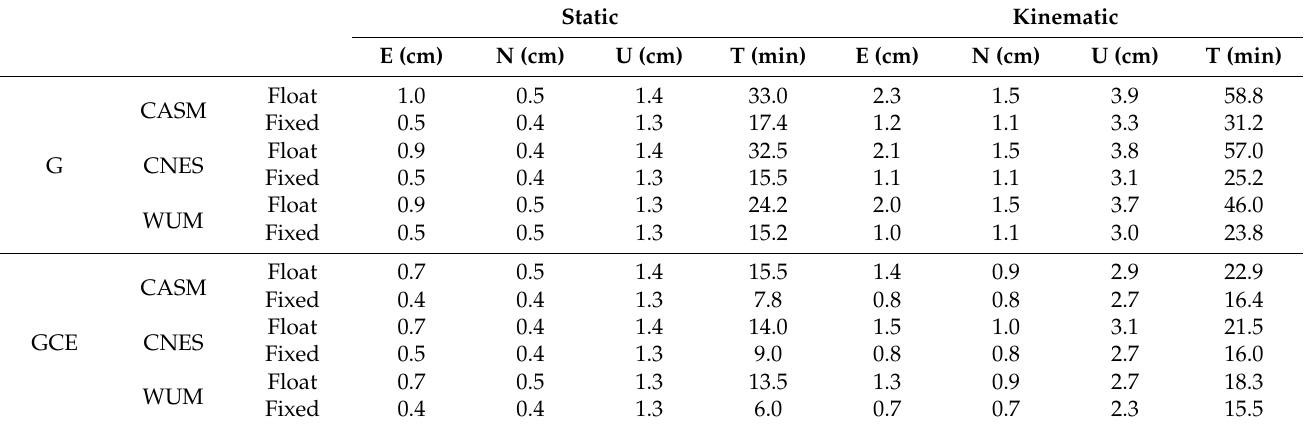
Table 4. The RMS results of positioning error and convergence time of the GPS-only and GCE float/fixed PPP static (left) and kinematic (right) of different institutions on DOY 300-306, 2021, for 22